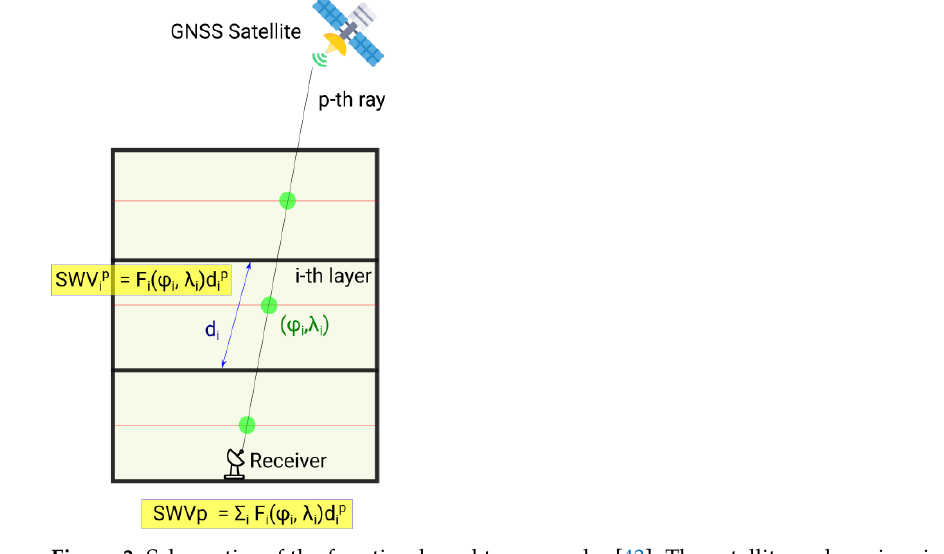
Figure 3. Schematics of the function-based tomography [43]. The satellite and receiver images are originaly made by Freepik (https://www.freepik.com) and Flaticon (https://www.flaticon.com/) (accessed on 10 June